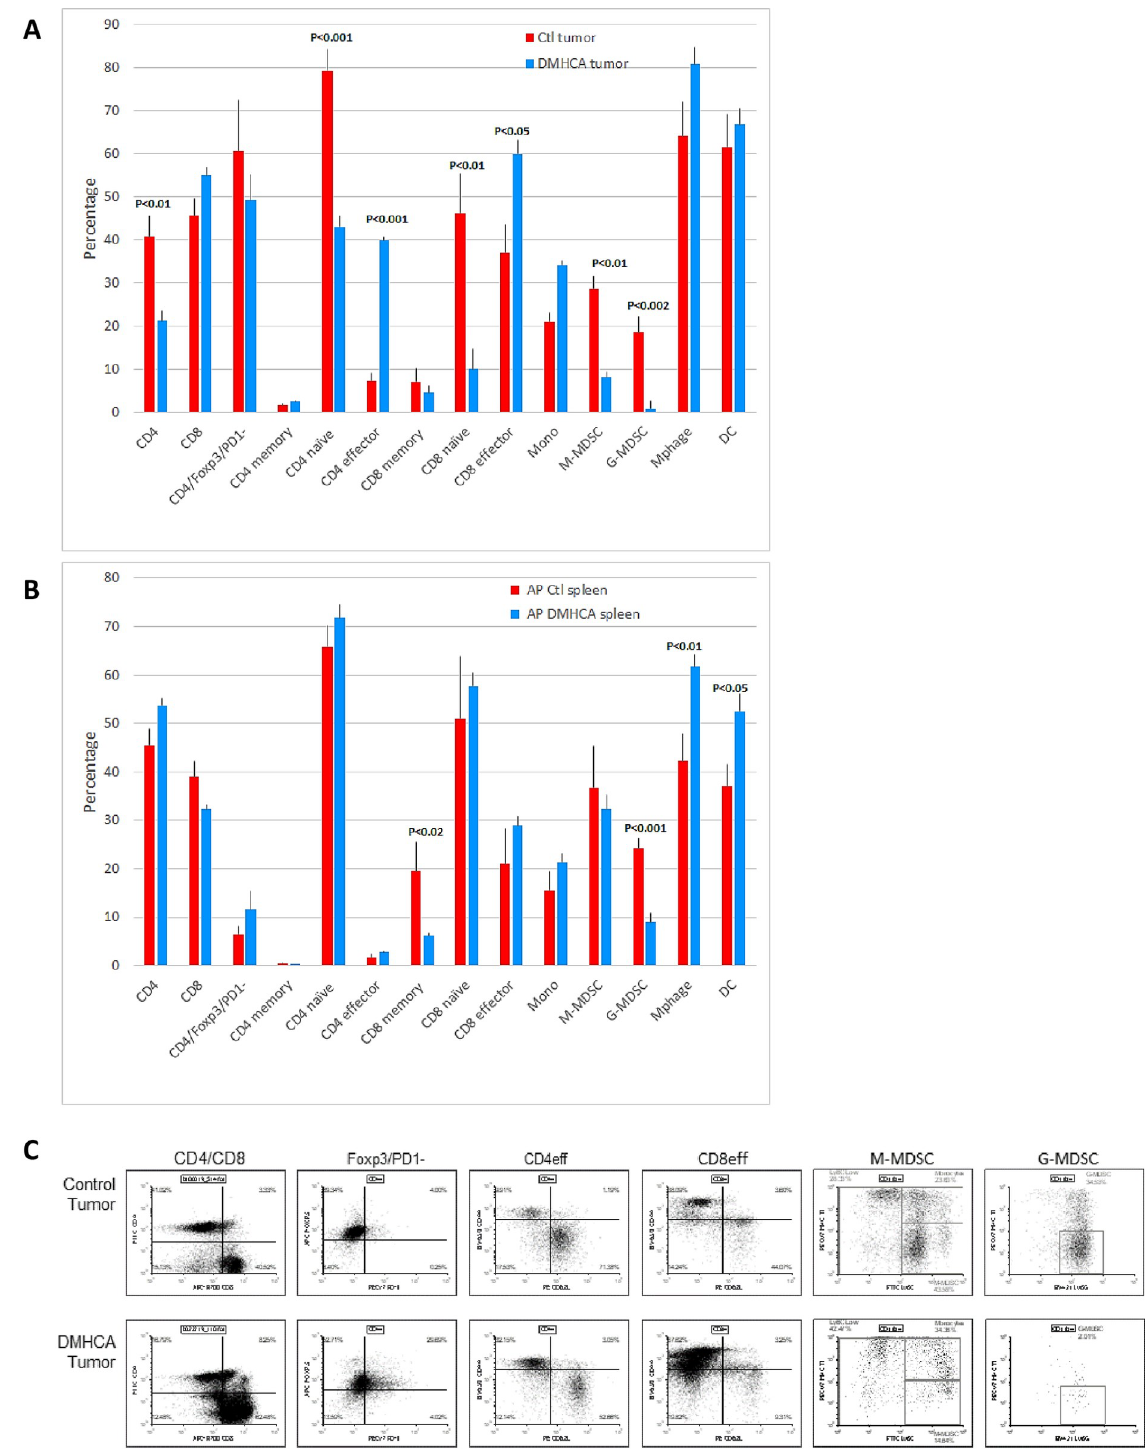
Fig 5. DMHCA reduces tumor infiltrating MDSC and increases CD4 + effector T cells. A , Flow cytometry analysis of immune cell subsets from tumor infiltrates and spleen after DMHCA treatment. There was a significant increase in CD4 effector T cells and a reduction in M-MDSC and G-MDSC in tumors as well as a reduction of G-MDSC in the spleen. N = 5 per group. G, granulocytic; M, monocytic. Statistical significance was determined by the two-tailed Student’s t test. B , Representative FACS analyses of tumor infiltrates from control and DMHCA-treated